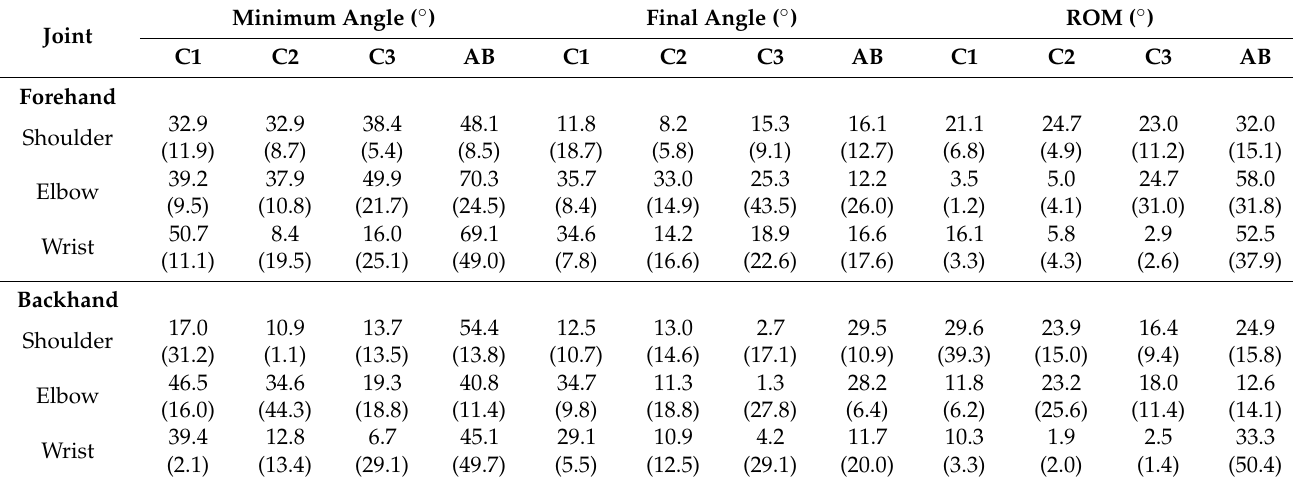
Table 2. Shoulder, elbow, and wrist joint angles between Classes 1, 2, 3, and AB participants while performing table tennis forehand and backhand topspin